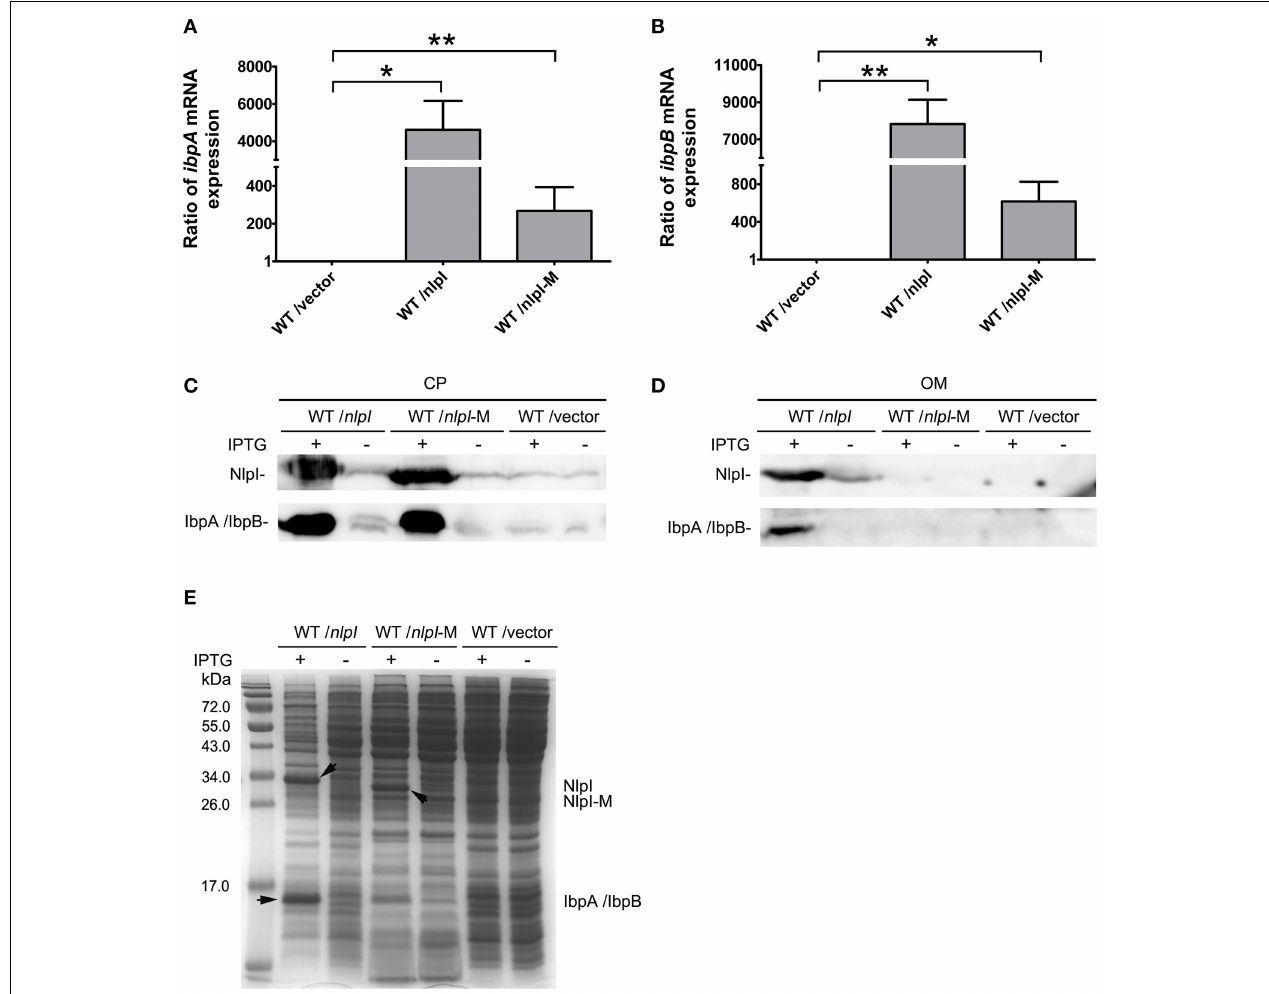
FIGURE 5 | NlpI mediated IbpA and IbpB localization to outer membrane. (A, B) qRT-PCR showed that the mRNA levels of ibpA (A) and ibpB (B) by over-expression of nlpI or nlpI -M were increased dramatically, compared with control. (C) Western blot probed with anti-NlpI and anti-IbpA antibody showed that over-expression of nlpI or nlpI -M induced IbpA and/or IbpB in CP. (D)